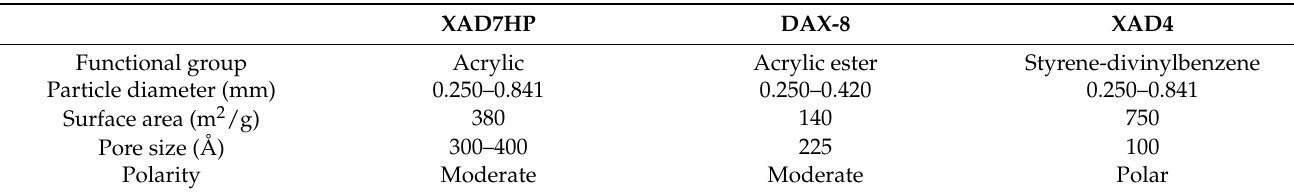
Table 1. Chemical and physical properties of different macroporous resins